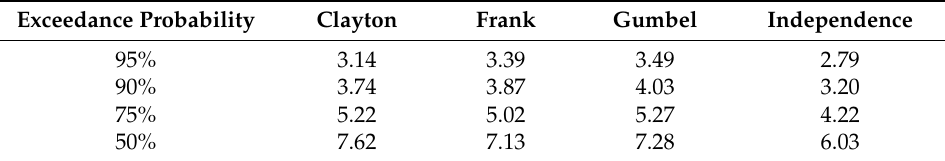
Figure 7. Cumulative exceedance probability curves in the cases of Independence, Clayton, Frank and Gumbel copulas. Table 6. Runoff of a given joint design frequency for tested models (10 8 m 3 ).